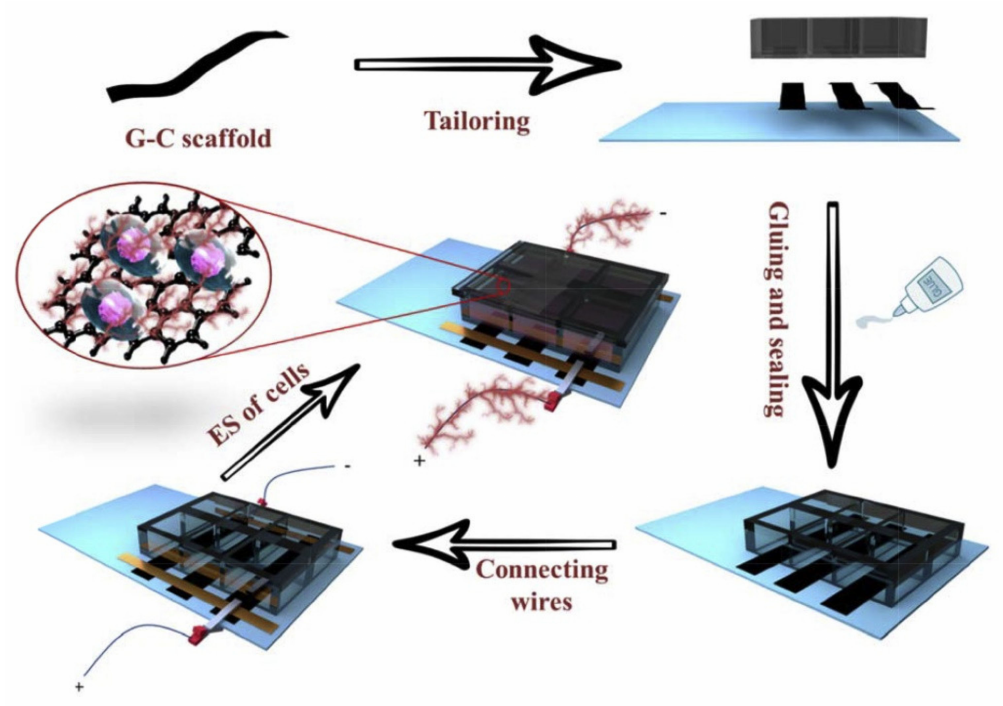
Figure 3. Schematic representation of the assembly and functionality of a G-C-based electrode for cellular electrostimulation [82]. Reproduced with copyright